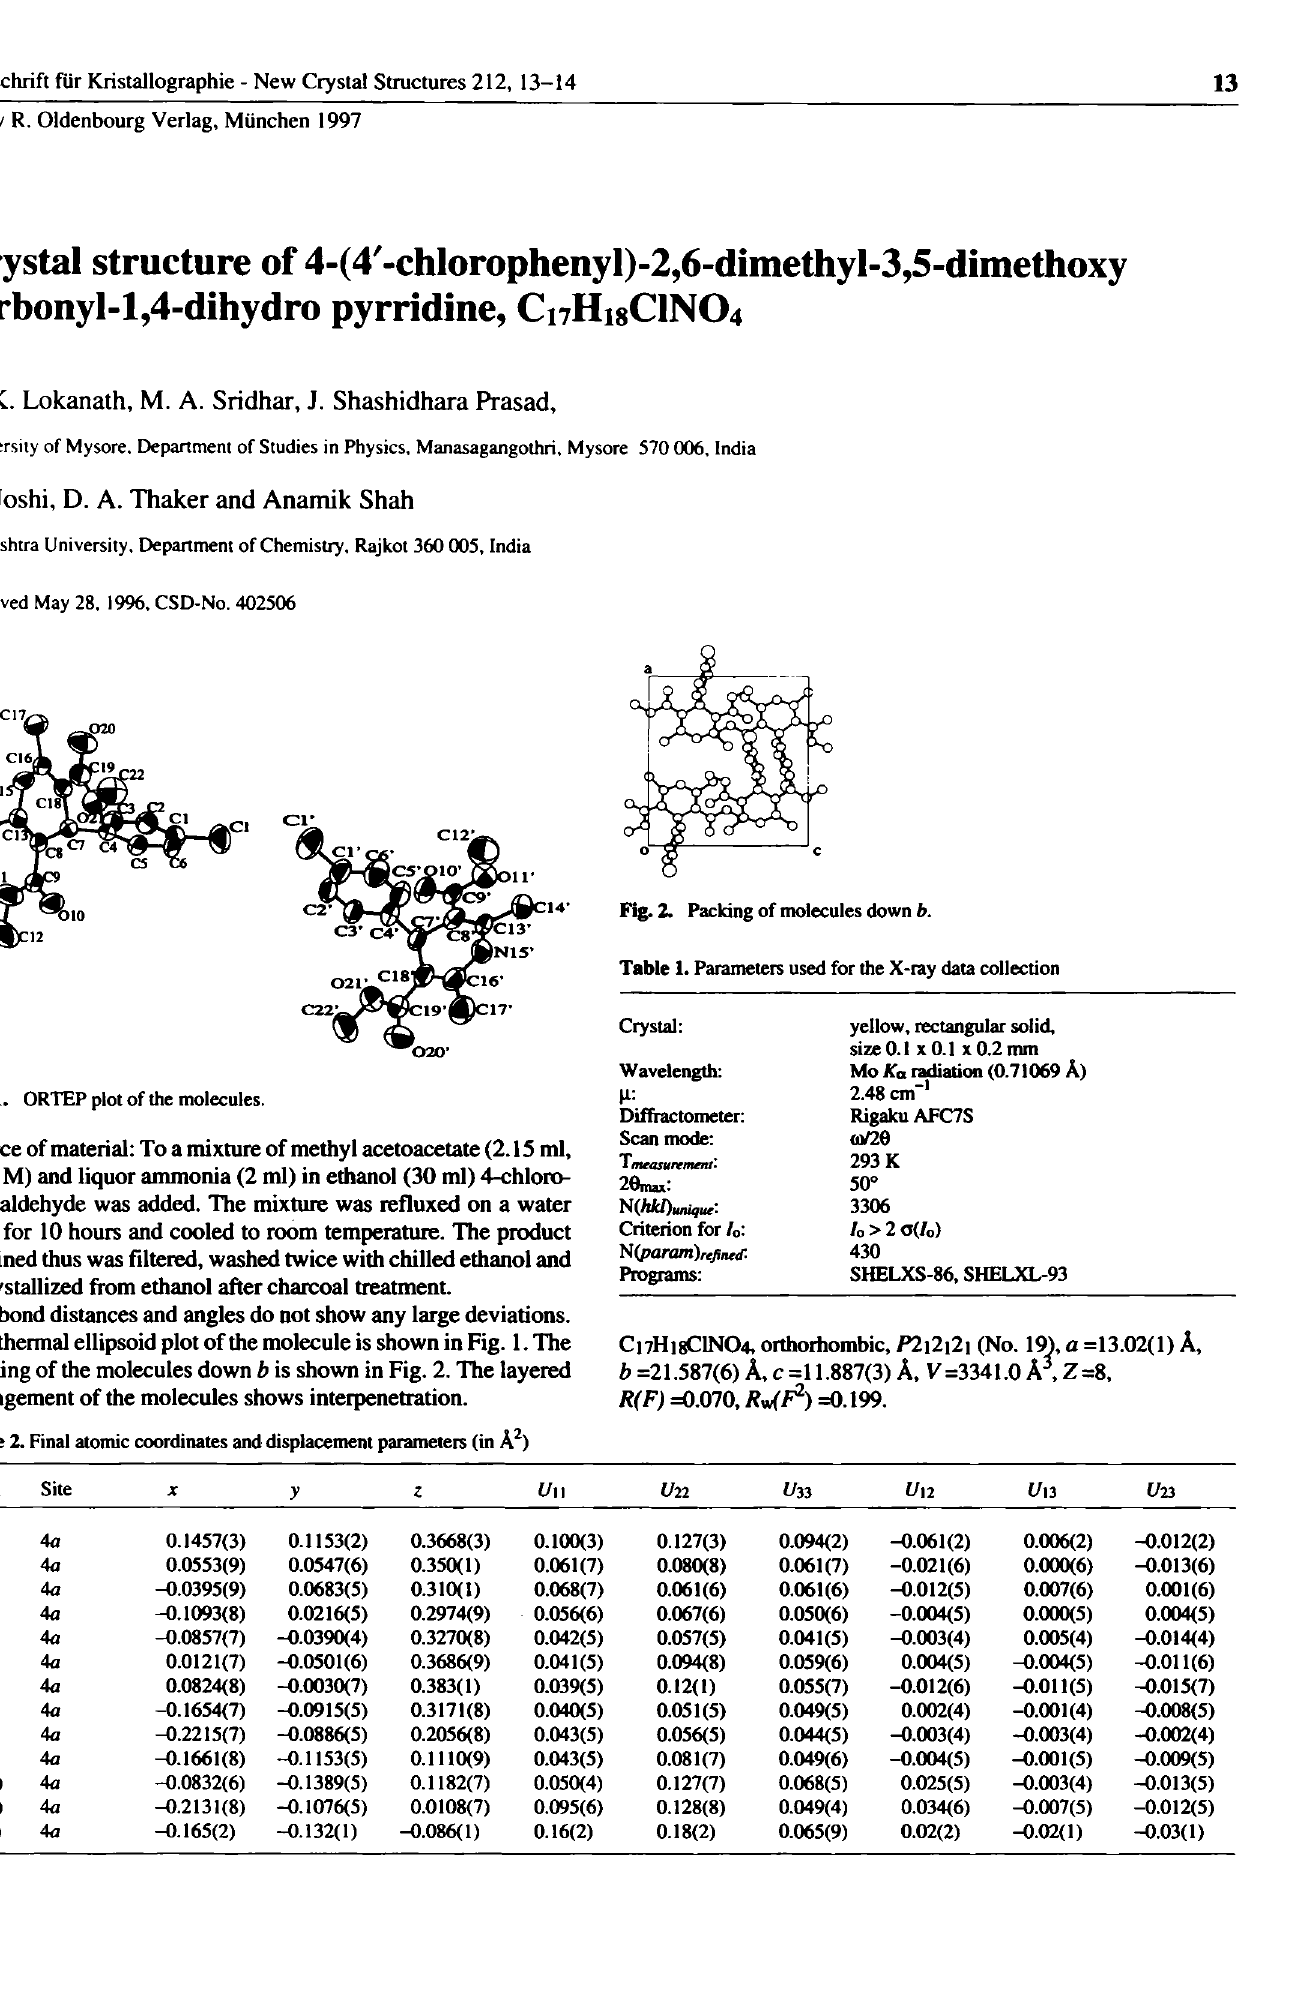
Fig. 1. ORTEP plot of the molecules.